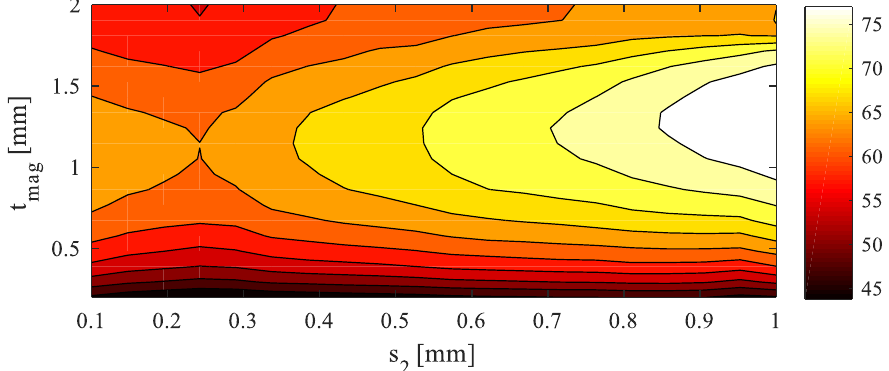
Figure 11. Map of the calculated quality factor Q 2 .